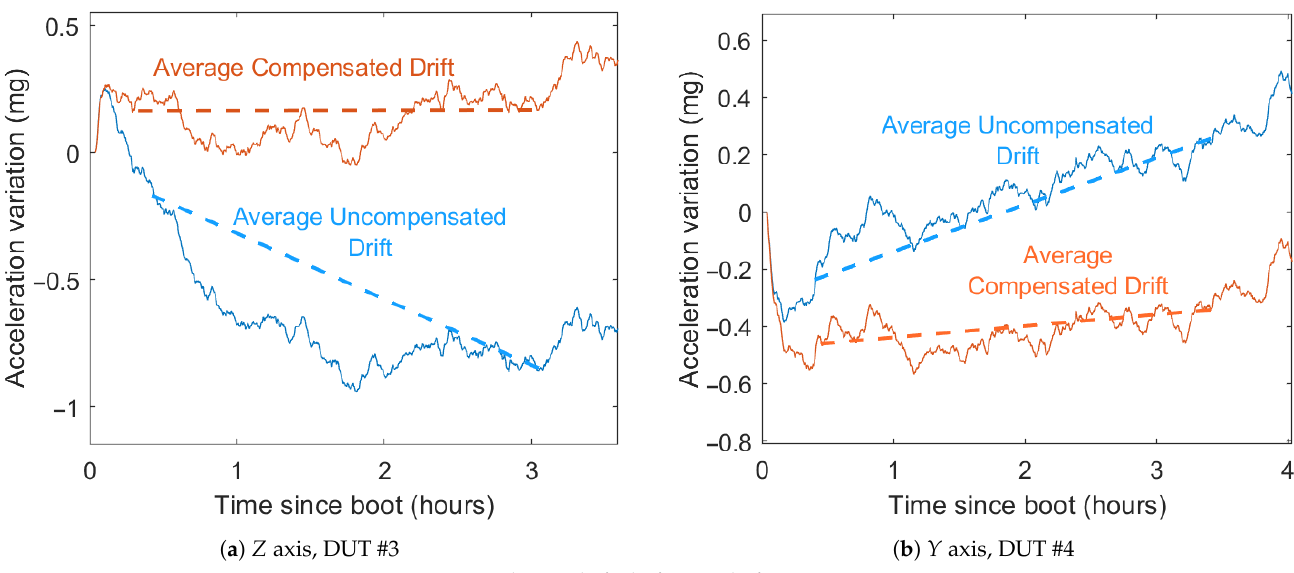
Figure 13. Cool start drifts before and after compensation. Table 8. Average acceleration drift between 30 min and 3 h after cool start (mg/h).